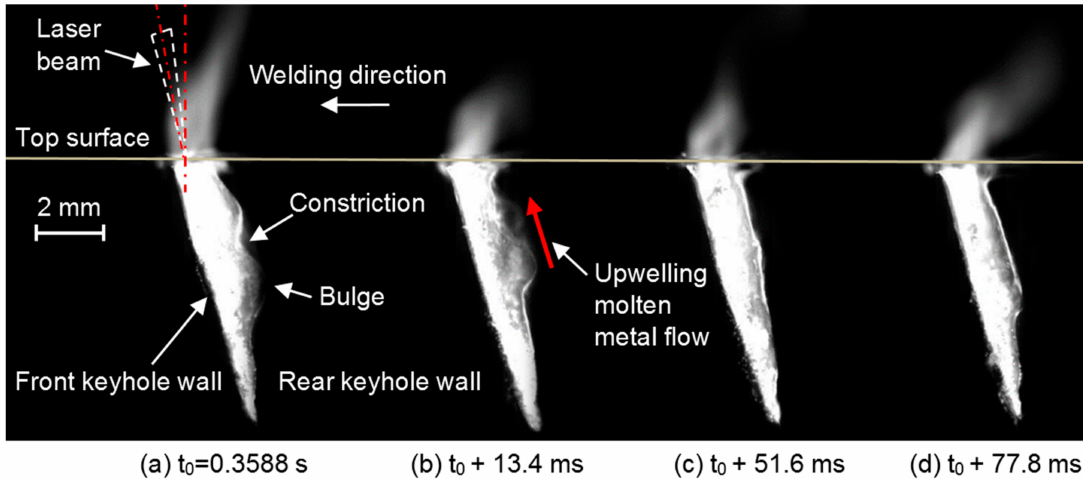
Figure 9. Images of the longitudinal keyhole and vapor plume in the backward welding (p = 10 kW, v = 1.8 m/min, ∆ = +10 mm).